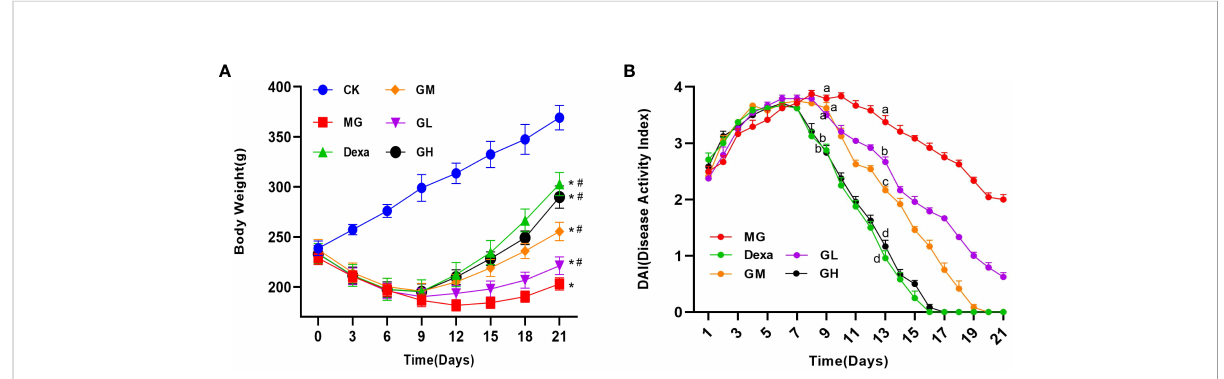
FIGURE 1 The general condition of rats in each group (rats received continuous intragastric treatment for 14 days after irradiation, i.e., from day 8 to day 21). (A) Change in rat body weight compared with the CK group (* p < 0.05) and the MG group ( # p <0.05). (B) Rat DAI. A letter common to two groups indicates a signi fi cant difference ( p >0.05). The absence of a common letter between two groups indicates a p- value of